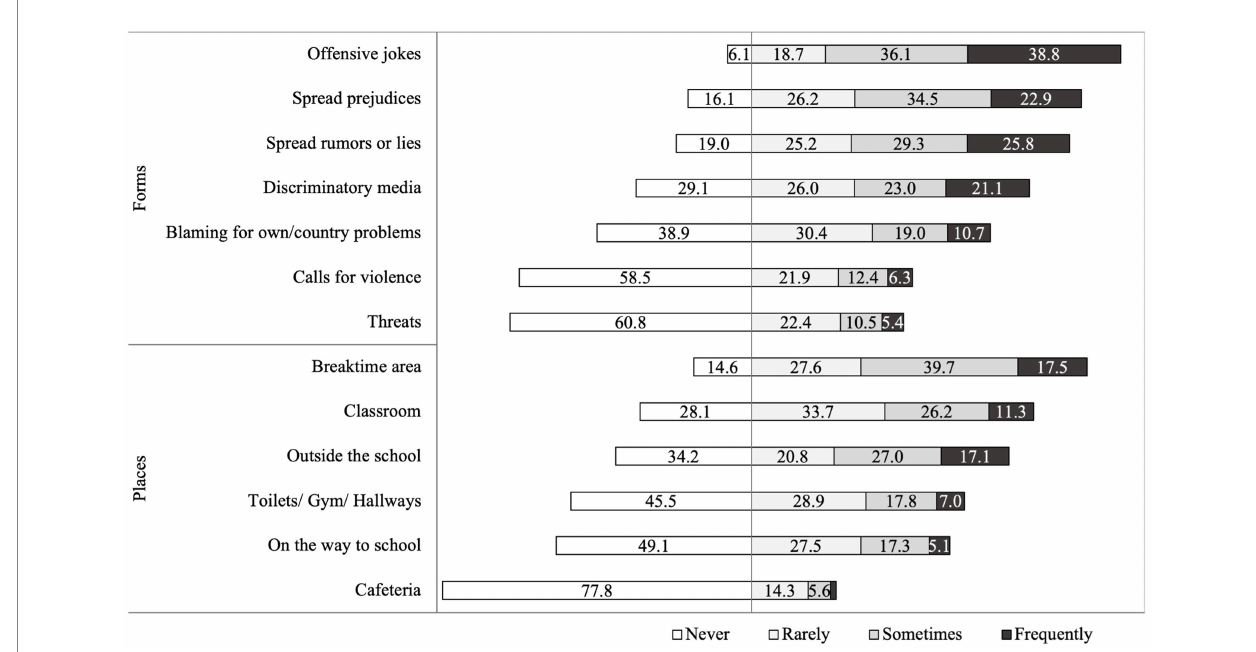
FIGURE 1 Types and places where offline hate speech occurs as reported by witnesses. The 1.4% of students who reported to had observed hate speech in the cafeteria “frequently” is not displayed for